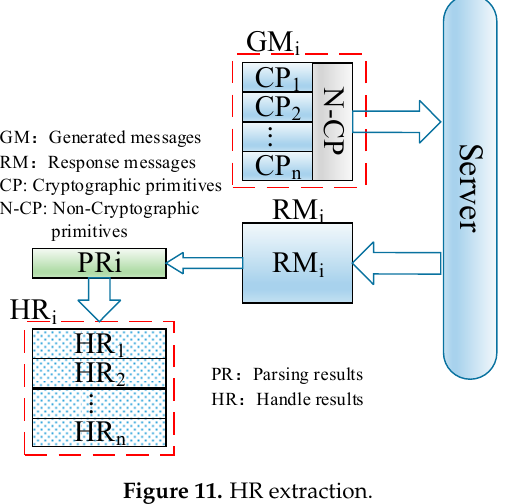
Figure 11. HR extraction.